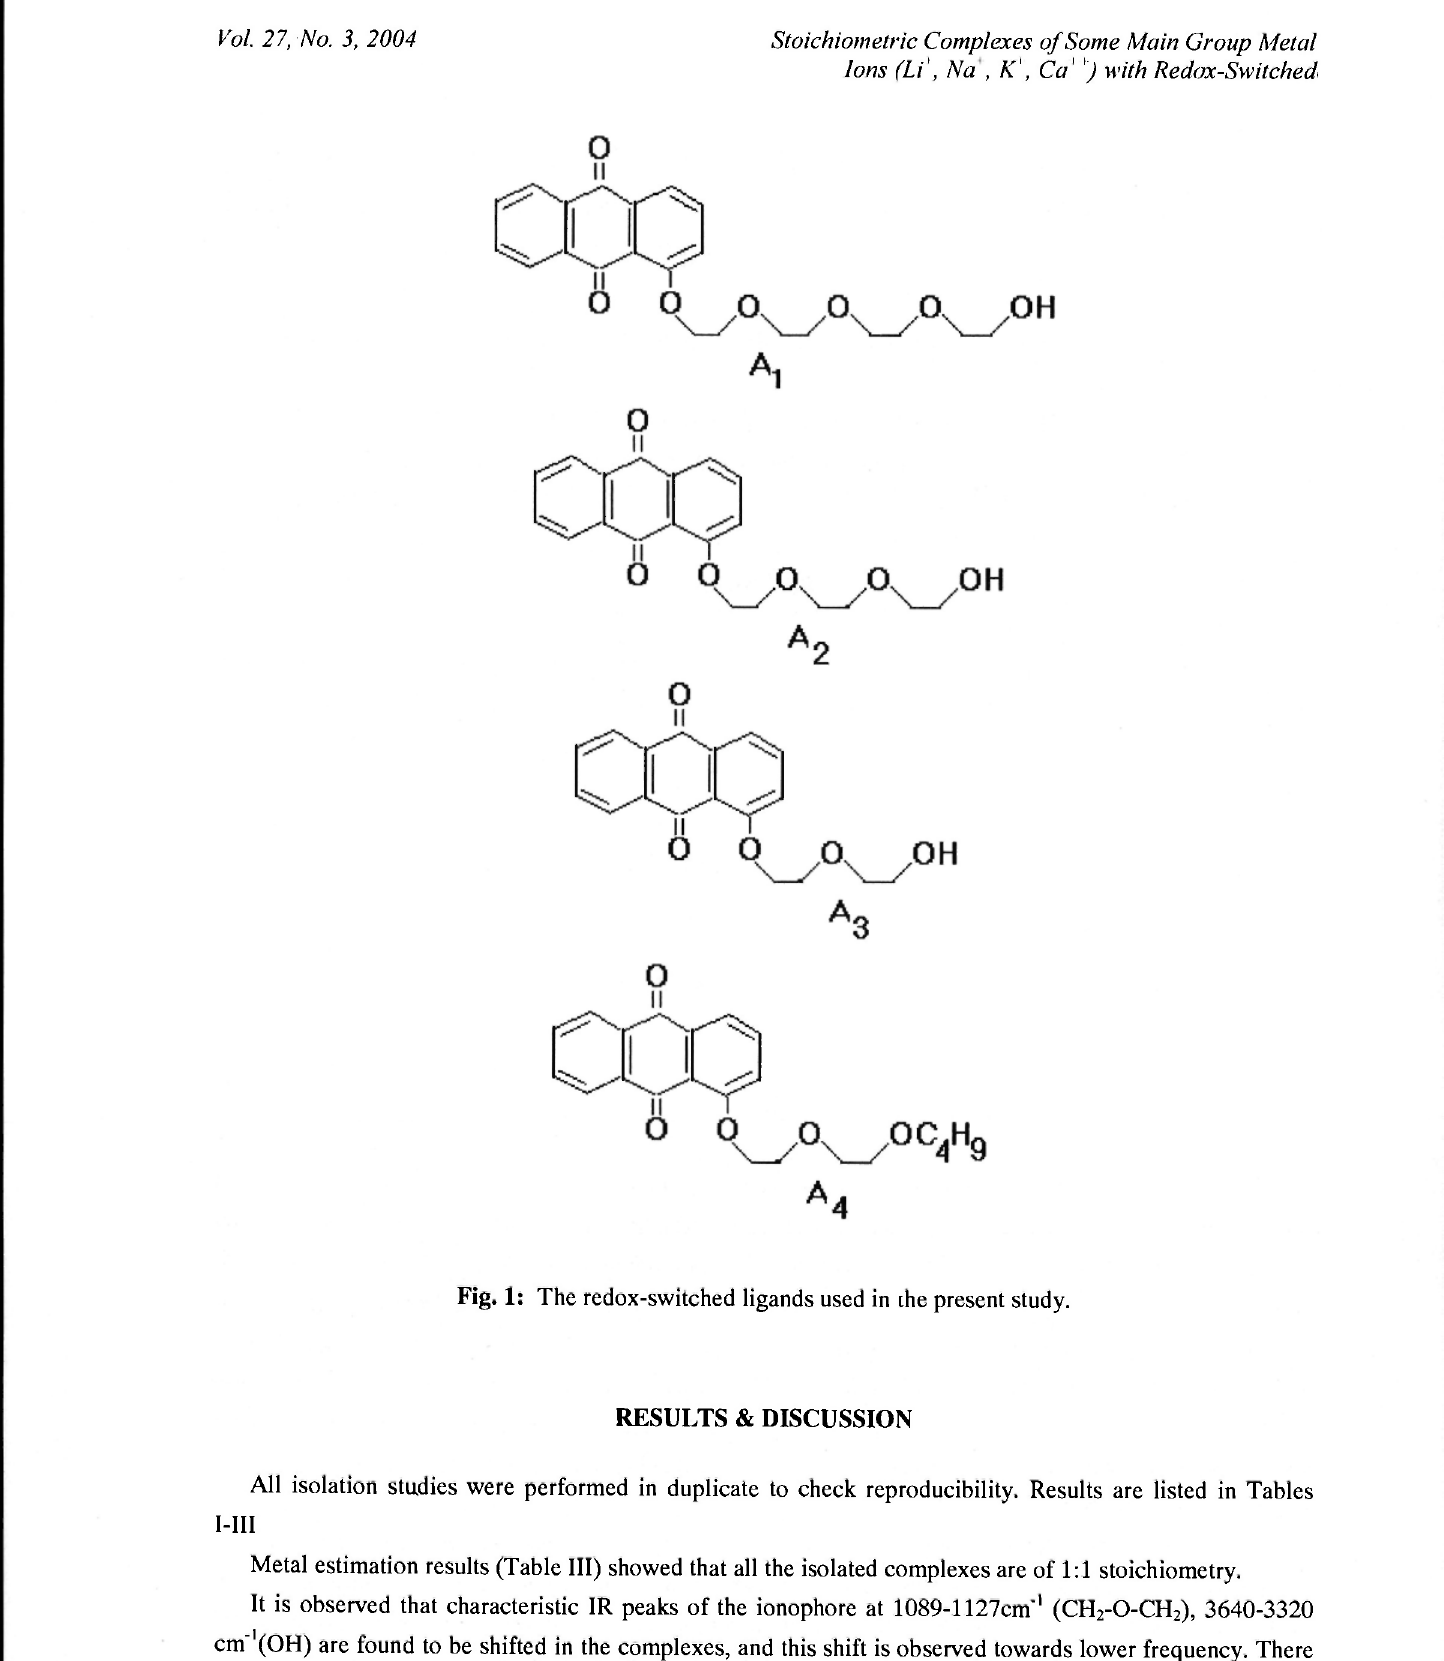
Fig. 1: The redox-switched ligands used in ihe present